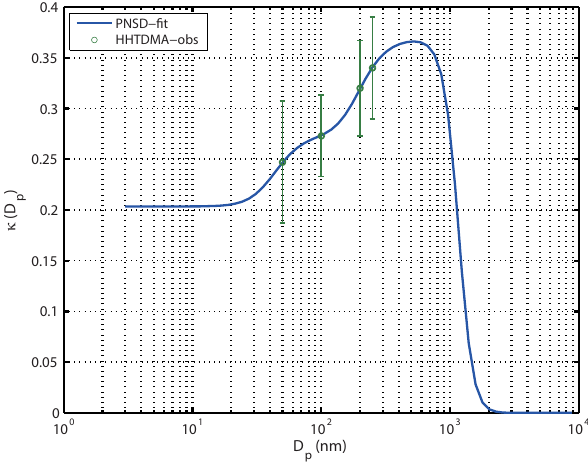
Figure 2. Size-resolved κ (blue line) and the corresponding mean values ± 1 standard deviation of observed κ (green circles and error bars) of particles with dry diameters of 50, 100, 200 and 250nm during the HaChi summer